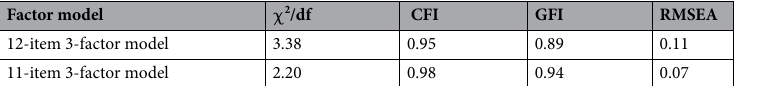
Factor model χ 2 /df CFI GFI